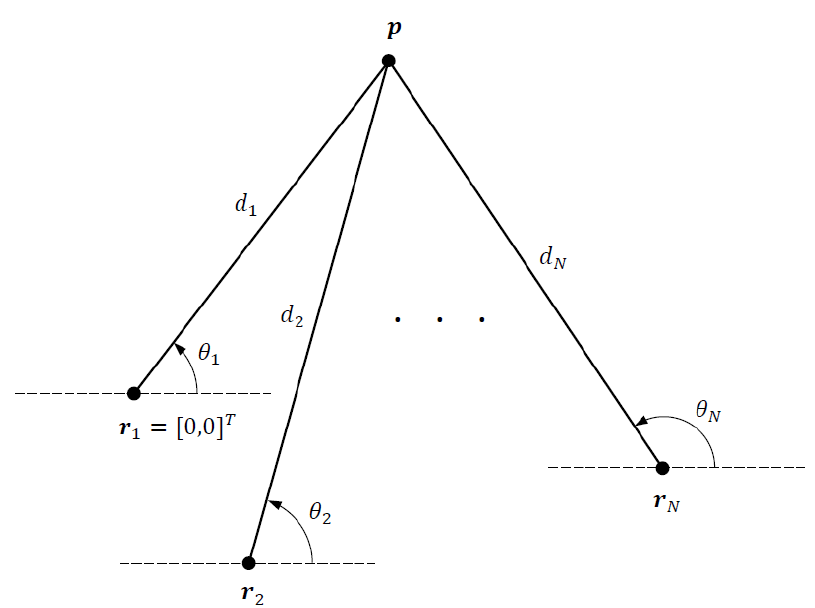
Figure 1. DRSS-AOA localization